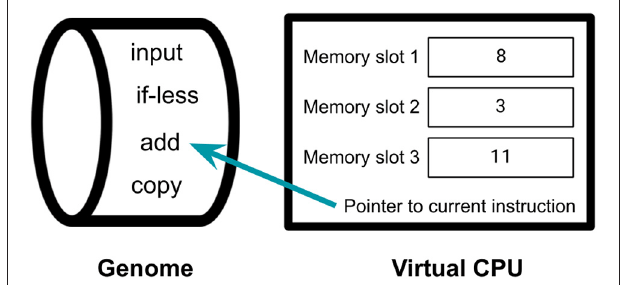
FIGURE 2 | An organism in Avida. Genomes of organisms in Avida are sequences of simple computer code. Each organism has a virtual CPU that is capable of running the code in its genome. This virtual CPU contains some memory, which can be used to store numbers that the organism is operating on. The CPU executes the instructions in the genome in sequence. In this example, the organism is currently executing the “add” instruction, which takes the number in the first memory slot, adds it to the number in the second memory slot, and stores the result in the third memory slot. In addition to performing mathematical computations, the instructions in the genome can allow the organism to make a copy of itself and place that copy elsewhere in the environment. Thus, organisms in Avida are able to reproduce via